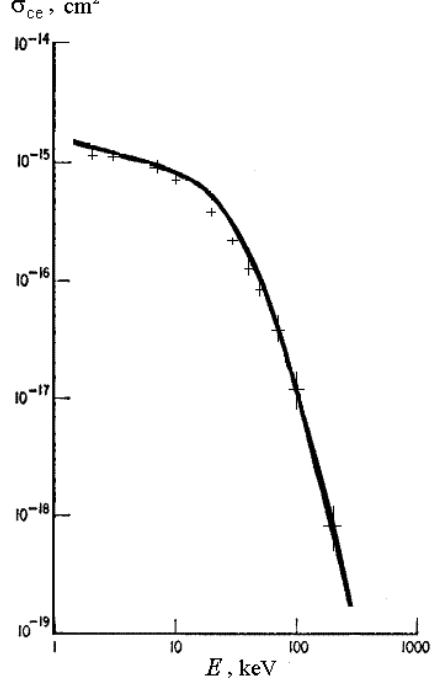
Figure 1. Comparison of the experimental dependence of σ ce (E) in Claflin (1970) for protons (thick curve) with approximation (crosses) in Jentsch (1984).